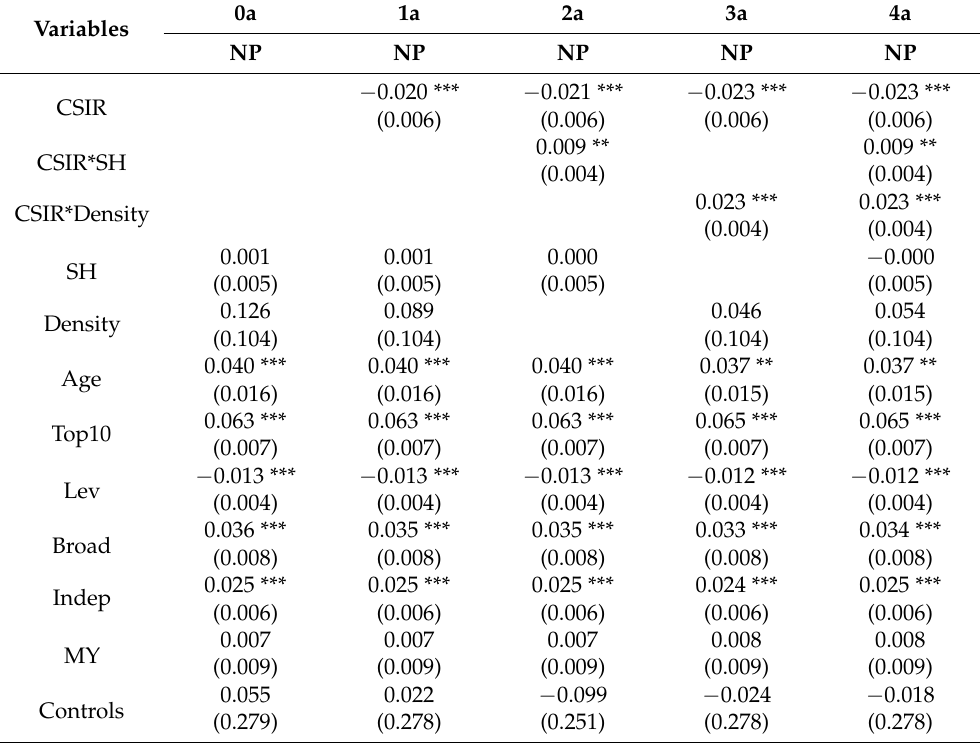
Table 3. CSR risk, social network, and financial